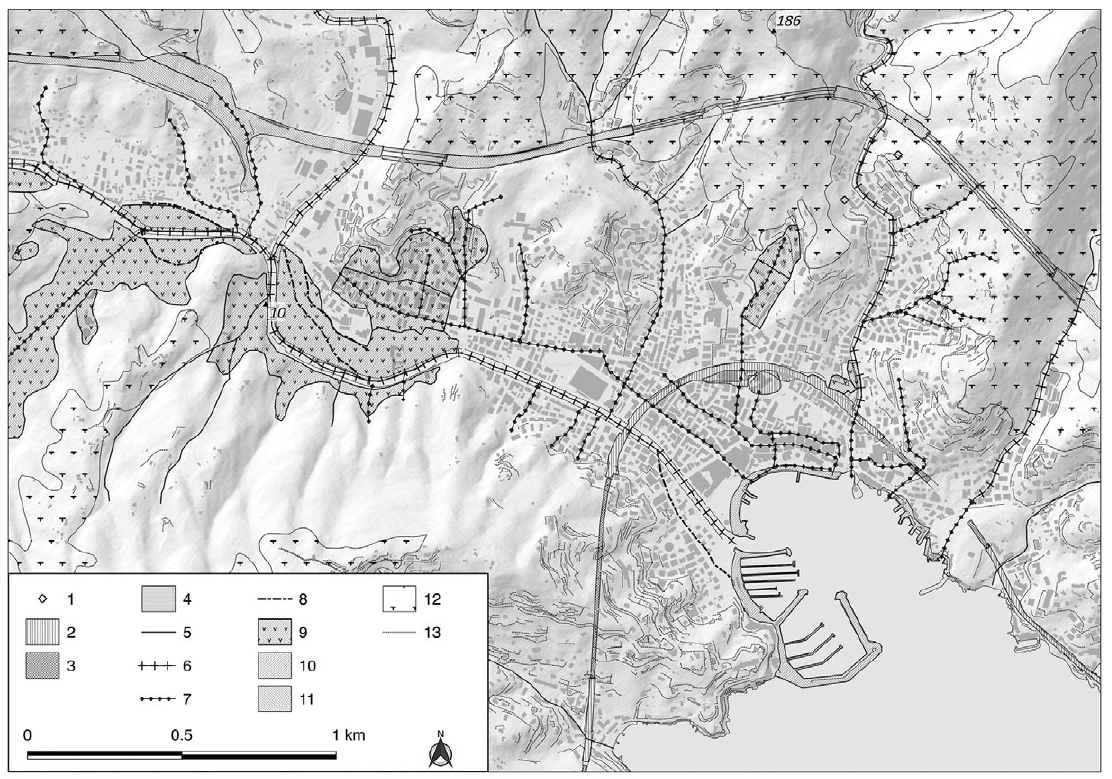
Fig. 12. Anthropocene sketch map of Rapallo city.